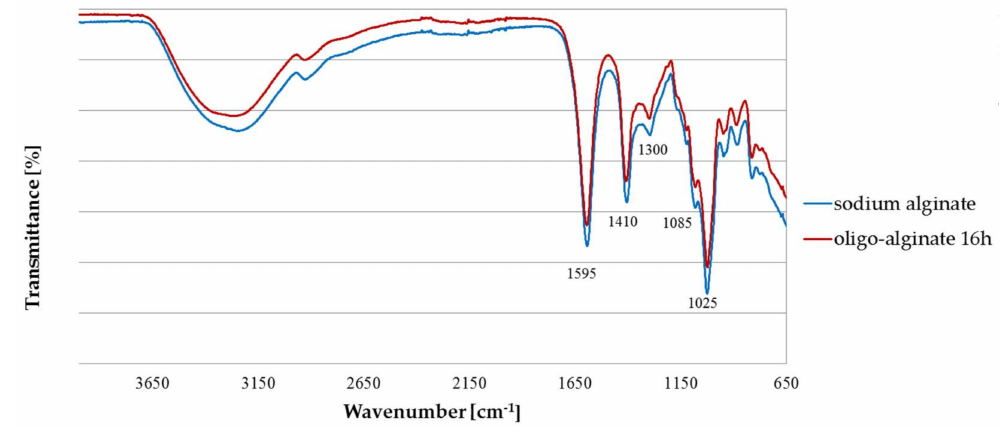
Figure 1. Fourier transform infra red (FTIR) spectra of sodium alginate and oligo-alginate obtained after 16 h